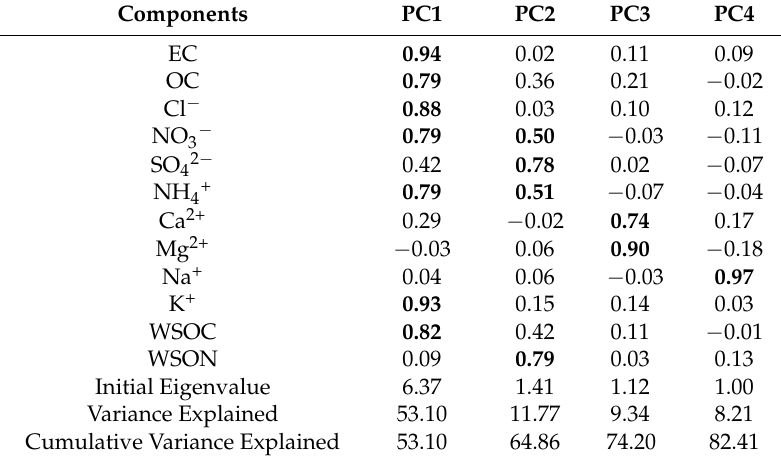
Table 2. Principle components analyses (PCA) analysis results of PM 2.5 and WSON (numbers in bold highlight the components with